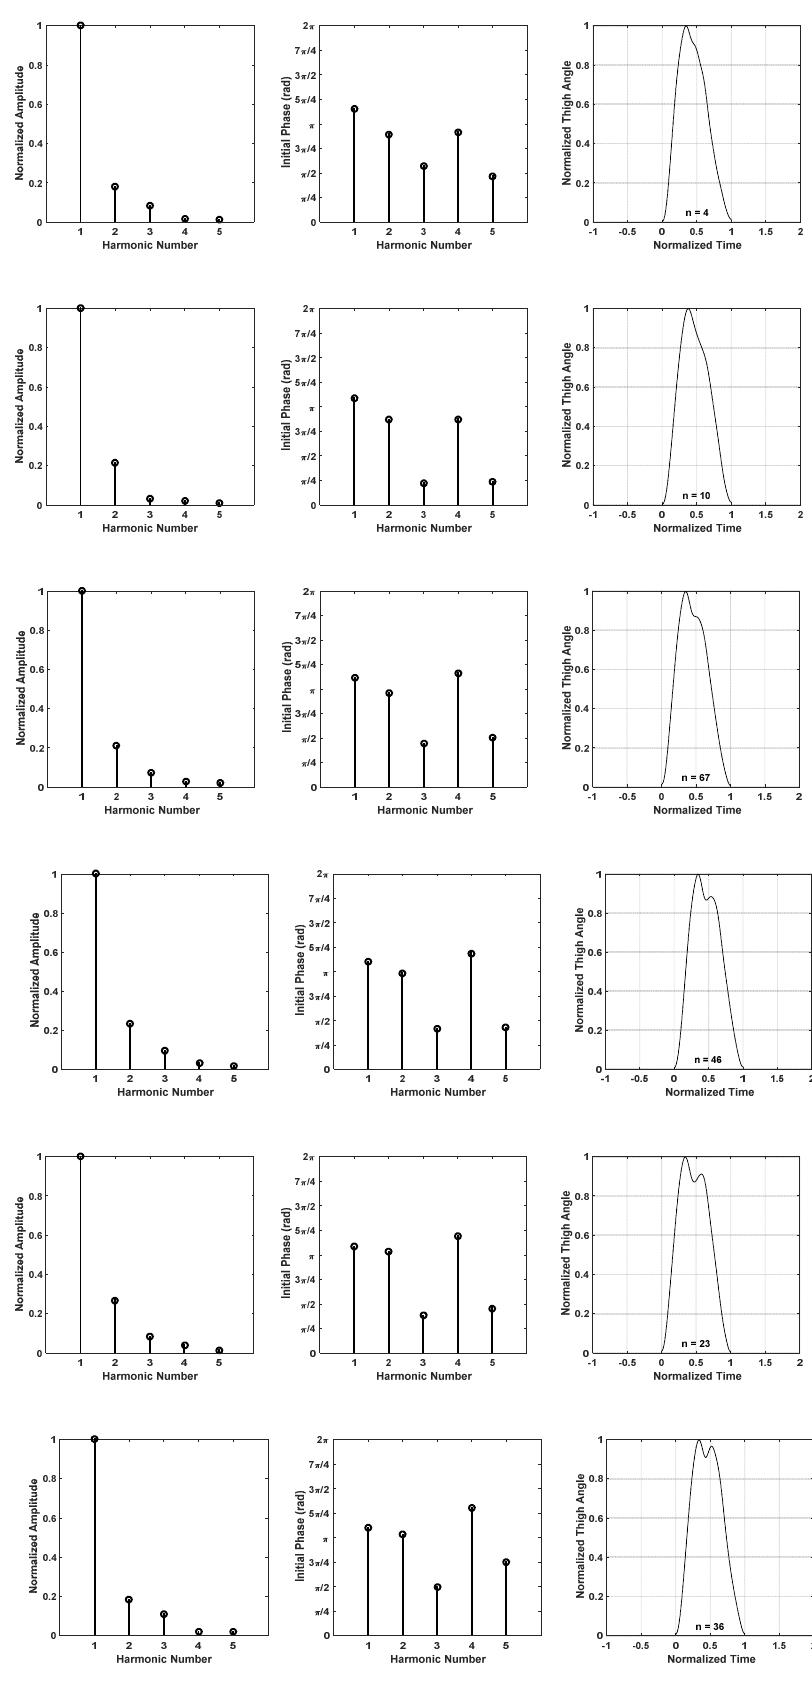
Figure 12. Harmonic models for six commonly observed thigh angle patterns.